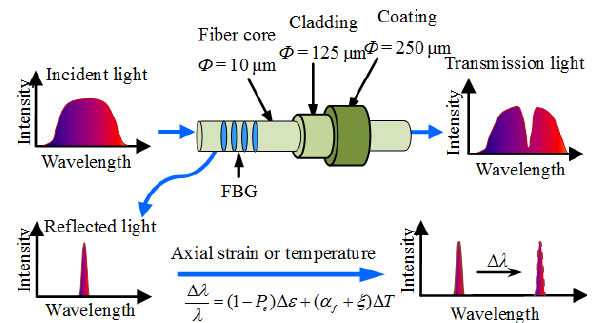
Fig. 2 Schematic diagram of the strain sensing